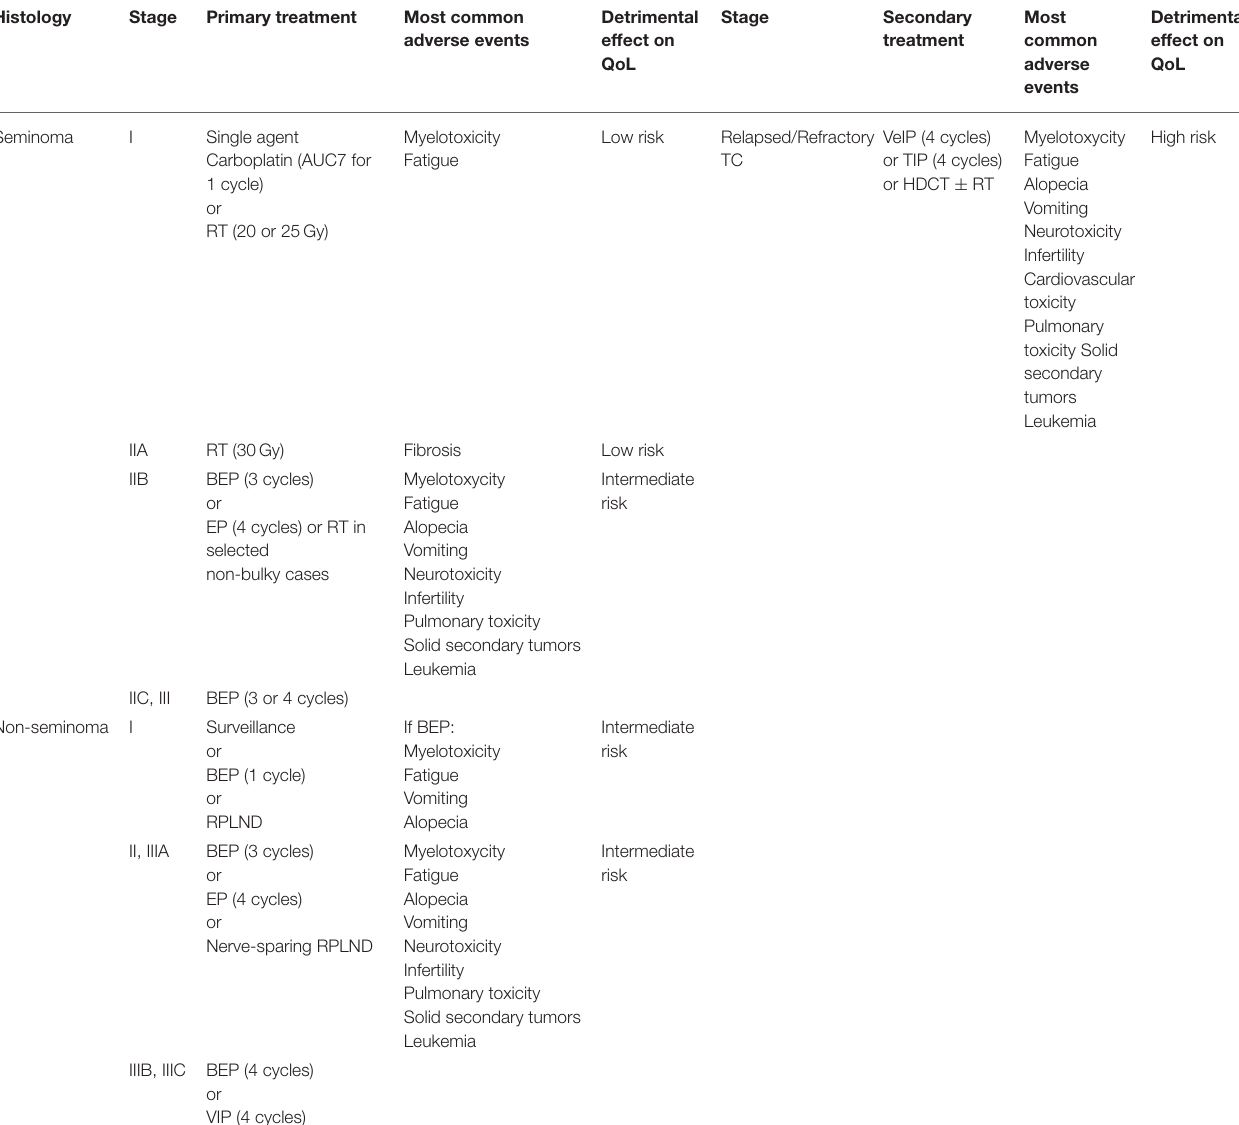
TABLE 1 | Therapeutic strategies, clinical complications, and correlation with QoL.